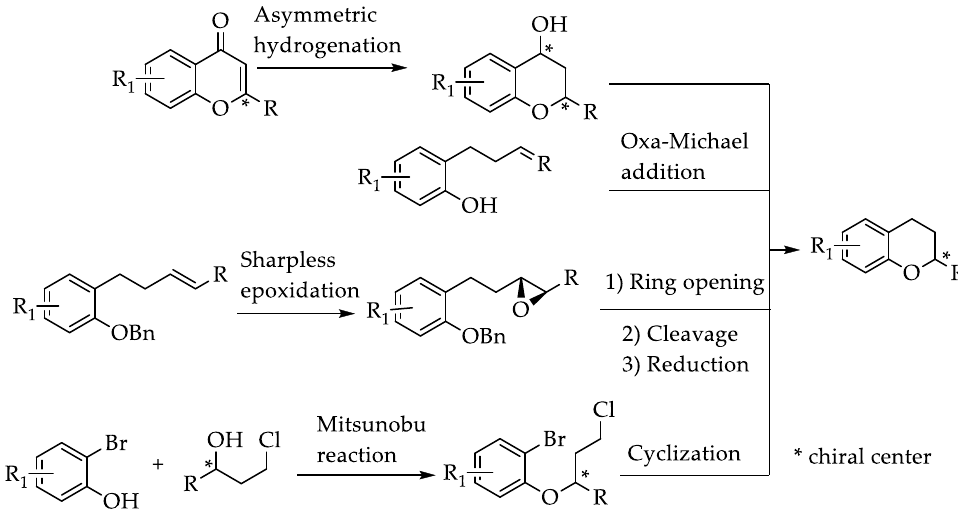
Figure 1. Representative bioactive 2-substituted chromanes.